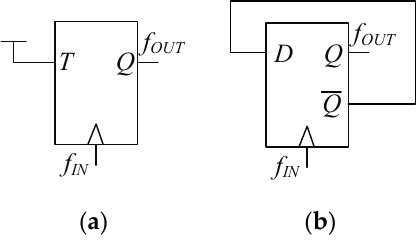
Figure 1. DIV2: ( a ) based on TFF; ( b ) based on DFF.